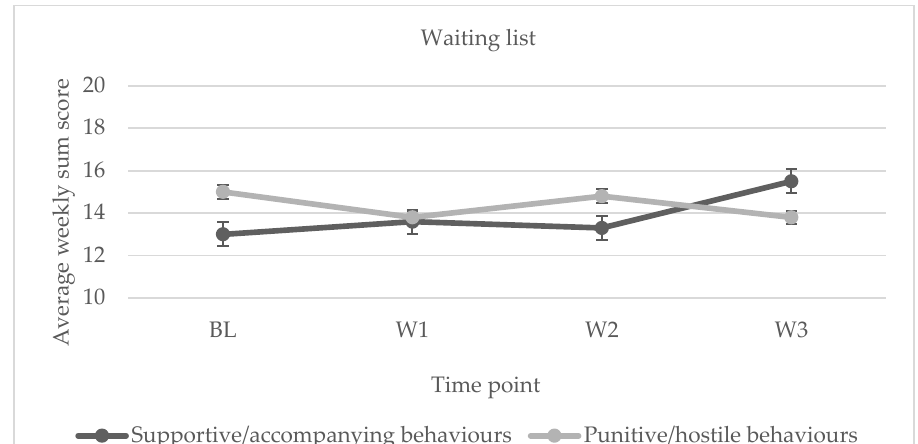
Figure 3. Evolution of family interactions for the waiting list group (control). Note. Supportive/ac- companying and punitive/hostile interactions over the three weeks the intervention was imple- mented. Error bars show the standard error of the mean (SEM).